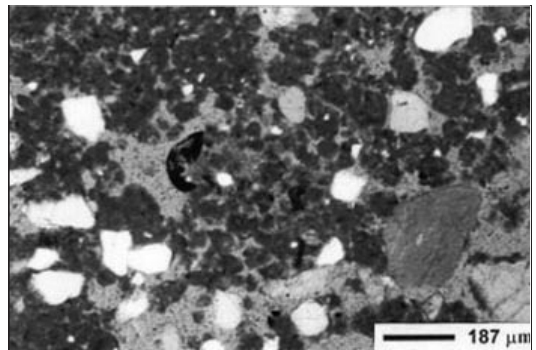
Figura 3. Fotomicrografia em luz plana de área sob influência da fauna do solo do horizonte Bi1 do CeTb (P5), mostrando a microestrutura granular.